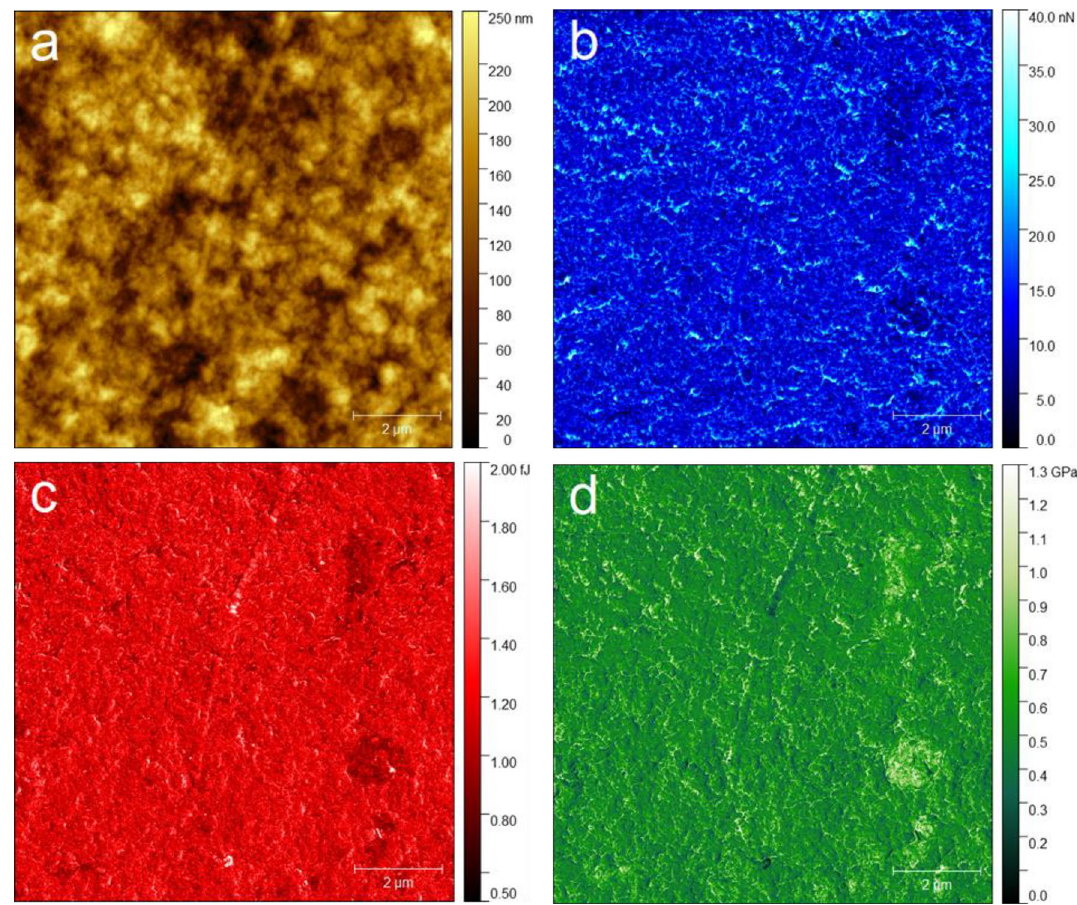
Figure 4. Comparison of different AFM images: ( a ) topography, ( b ) adhesion force, ( c ) energy dissipation, and ( d ) Young’s modulus. The image size is 10 × 10 μm.